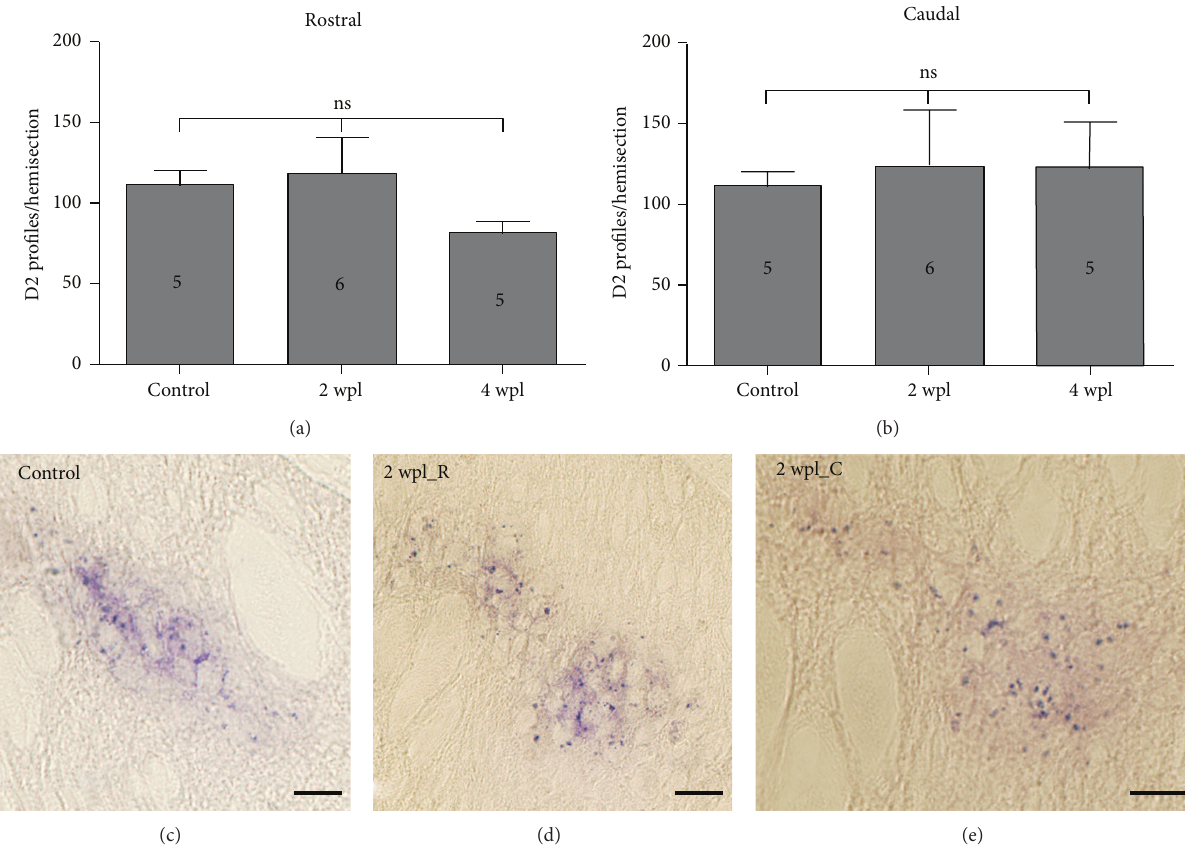
Figure 6: D2 in situ profile numbers do not change after a complete spinal cord injury. (a) Quantification of D2 profiles in the rostral spinal cord. (b) Quantification of D2 profiles in the caudal spinal cord. (c) Photomicrograph showing the D2 receptor expression in the spinal cord of a control larva. (d) Photomicrograph showing the D2 receptor expression in the rostral spinal cord of a 2wpl larva. (e) Photomicrograph of the D2 receptor expression in the caudal spinal cord of a 2wpl larva. In all microphotographs dorsal is at the top. Scale bars = 50 𝜇